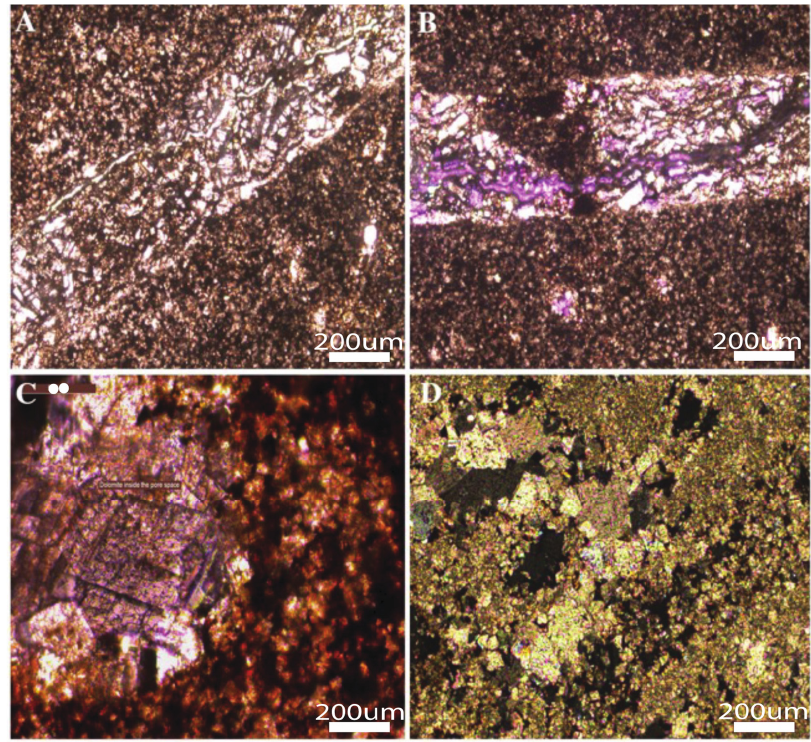
Figure 5. ( A , B ) photomicrographs showing the fine grain of dolomite crystals cross-cut by early dolomite crystals. ( C , D ) the aggrading increases of dolomite grains are obvious in the left part of ( C ; see the rhomboheral shape) and sharp contact between fine grain dolomite in upper right part and rhombohedral crystals of dolomite in upper and lower left part of ( D ).